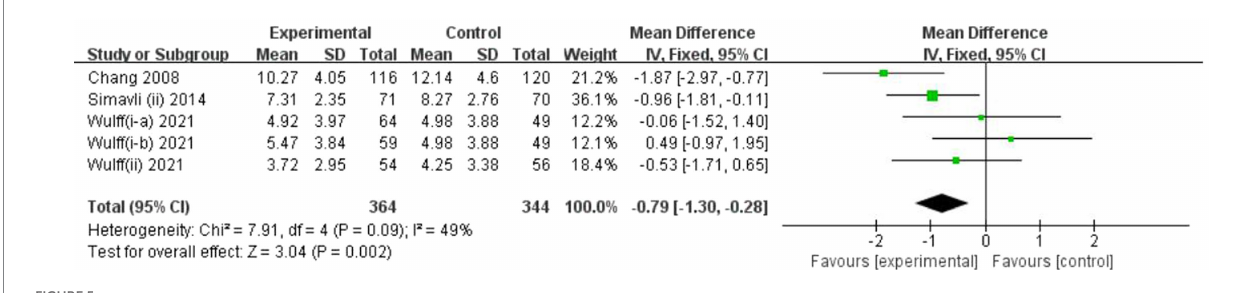
FIGURE 5 Forest plot of posttreatment depression outcome for comparing art-based intervention with control.